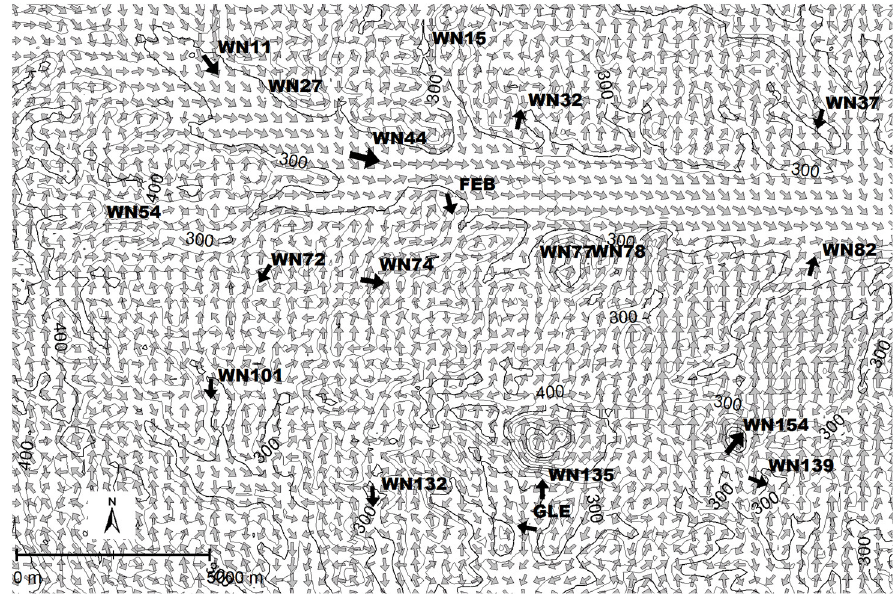
Figure 11. Simulated (grey) and observed (black) flow in the Feldbach domain for 16 October 2017 at 3.a.m. (only every second modelled vector is shown).